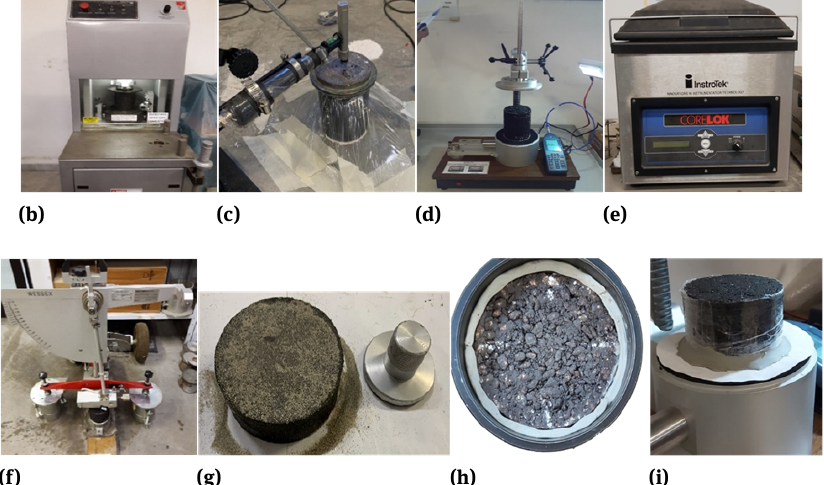
Figure 11: Materials and devices